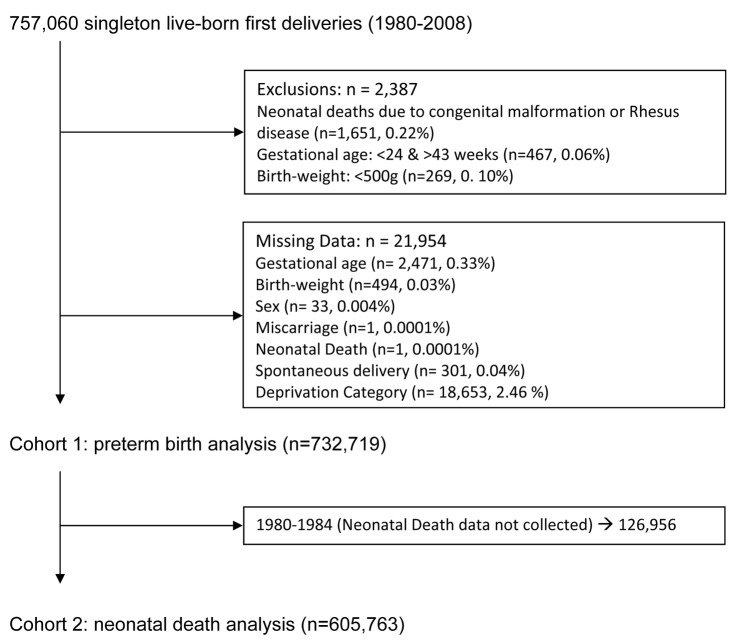
Selection of the study cohorts.